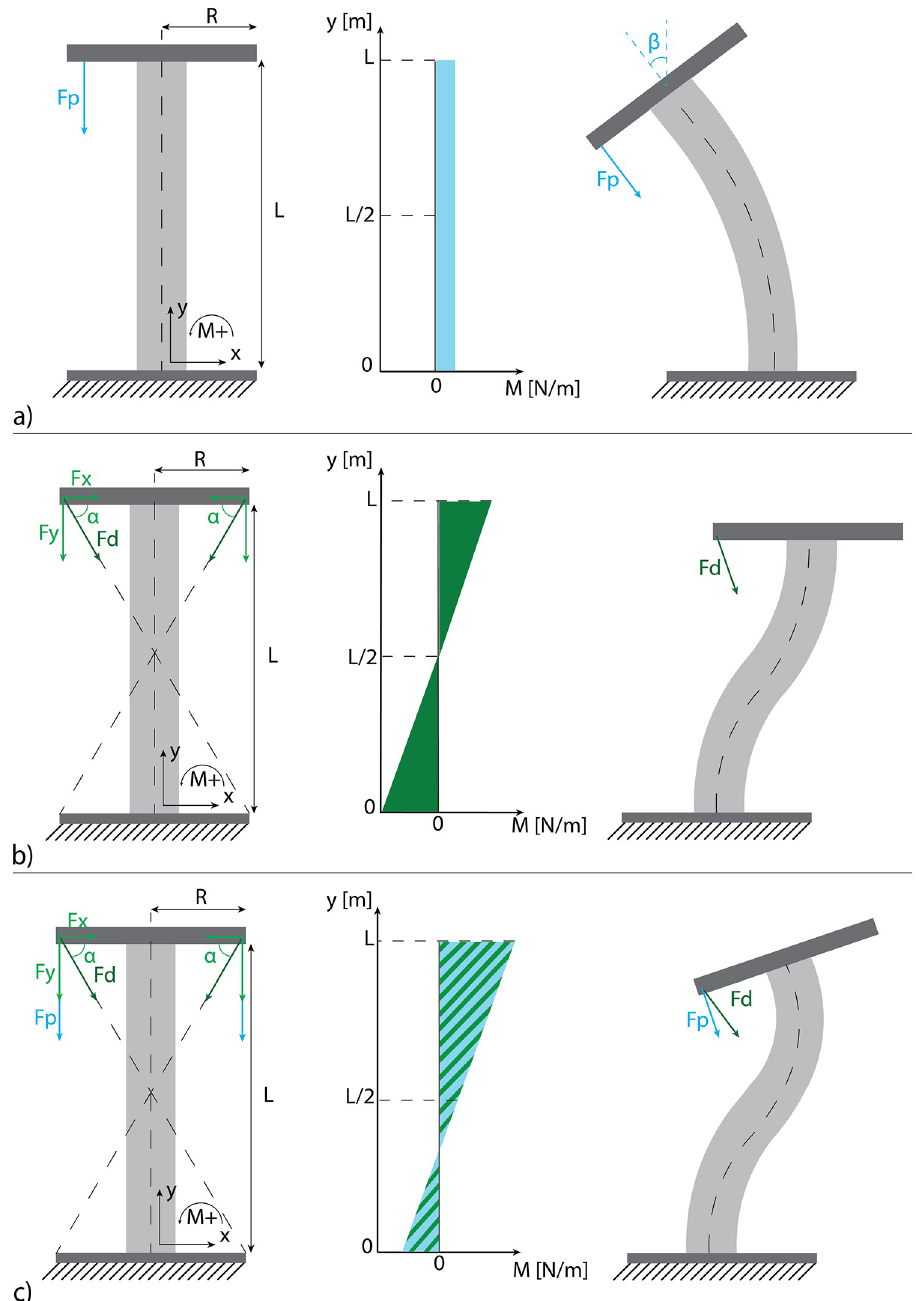
Fig 2. The three cable configurations presented in this work. Left: 2D representation of the segment, center: Corresponding bending moment diagram, right: Segment deforming under the applied pulling force. a) Parallel configuration, b) diagonal configuration, c) multi configuration. For the explanation of the used symbols, see the text. and can be split into the F and F components. When the cables cross each other at L/2, the x y segment will have a symmetric bending moment and, therefore, symmetric behavior, enabling a double-curved shape deformation mode as shown in Fig 2B. In this case, the end plate